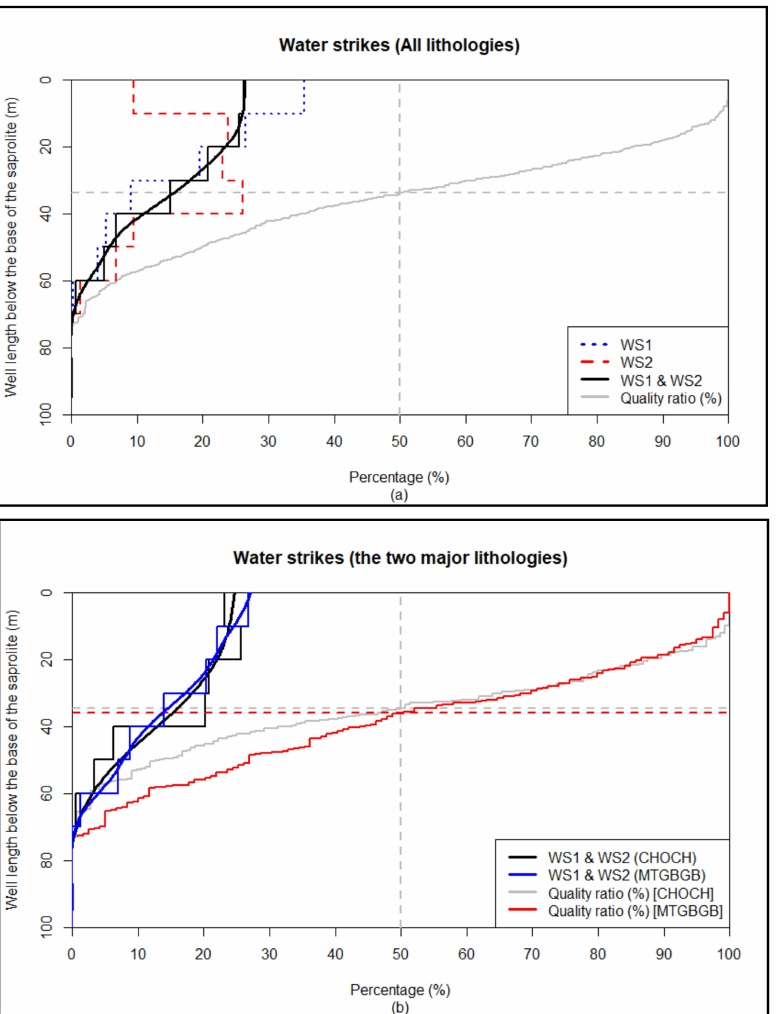
Figure 9. Vertical distribution of water strikes as a function of depth below the base of the saprolite in ( a ) all lithologies (NWS1 + NWS2 = 623; with NWS1 = 400 and NWS2 = 223), ( b ) Charnockitic Orthogneiss and Charnockites (CHOCH) (NWS1 + NWS2 = 190; with NWS1 = 129 and NWS2 = 61), and Biotite Granodiorite and Biotite Metagranodiorite (MTGBGB) (NWS1 + NWS2 = 171; with NWS1 = 107 and NWS2 = 64); WS1 and WS2 are respectively the first and second water inflow under the saprolite; Quality ratio is the ratio expressed as a percentage of the number of boreholes passing through a given